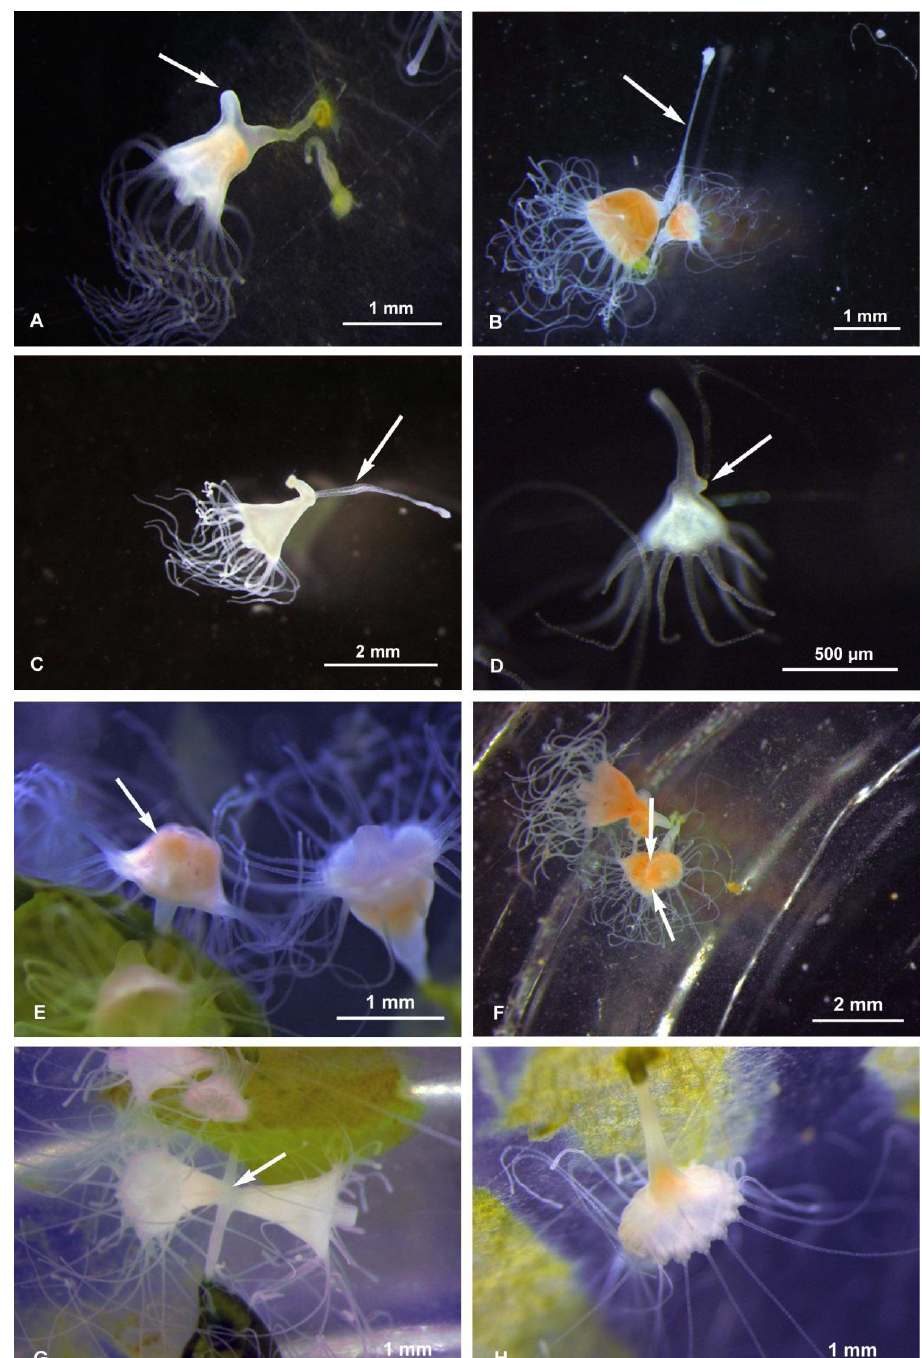
Figure 1. Sanderia malayensis polyps. ( A ) Budding type 2, with a developing stolon (arrow), ( B ) budding type 2, almost complete detachment of the “parental” polyp from the “child” polyp (on the right), by means of the tension exerted by the stolon (arrow), ( C ) budding type 4, the old stolon takes on a clavate shape while creating the choke for separation from the new stolon (arrow), ( D ) budding Type 6b, a freely floating bud that has already developed the tentacles, and a developing new stolon (arrow), ( E ) budding type 7, inverted polyp (arrow) exposing the gastroderm, ( F ) budding type 8, advanced tentacular cleavage with the polyp possessing two heads (arrows indicate the area of constriction between them), ( G ) budding type 8, two polyps that are completing the tentacular budding—in the center is the still common portion (arrow), ( H ) budding type 9 (strobilation), polyp (scyphistoma) starting